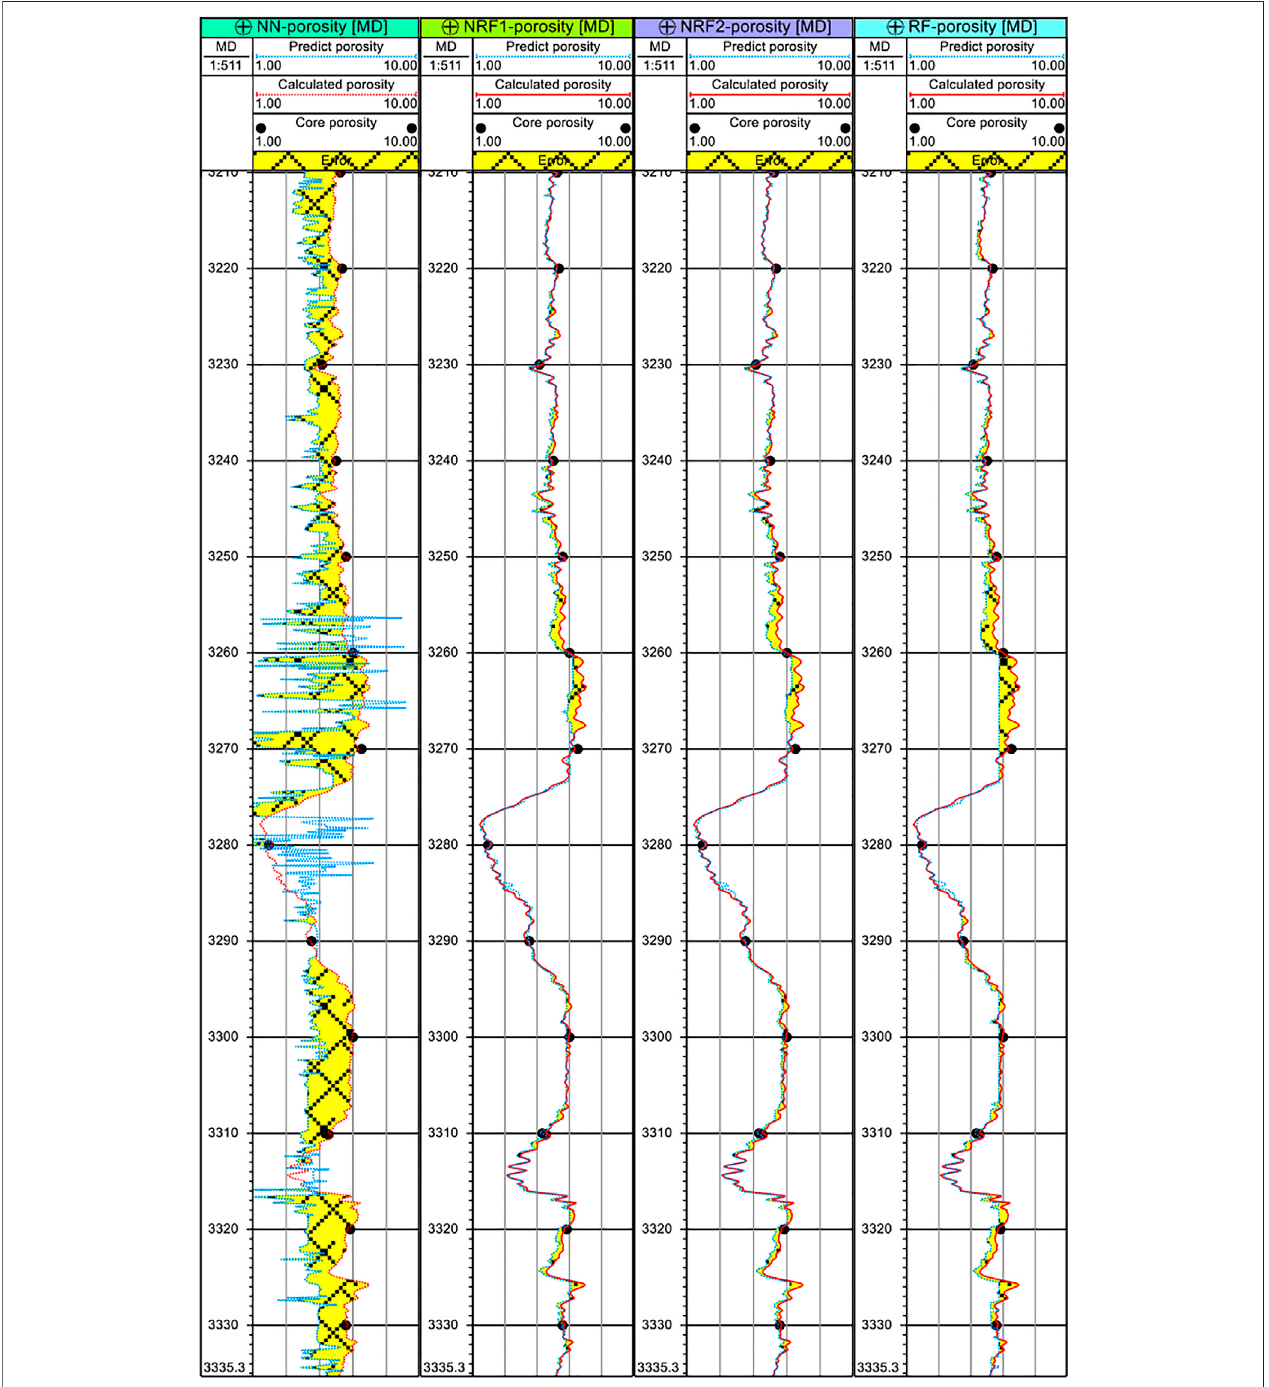
FIGURE 6 | Comparison results of different models for porosity (depth: 3210 – 3330 m).